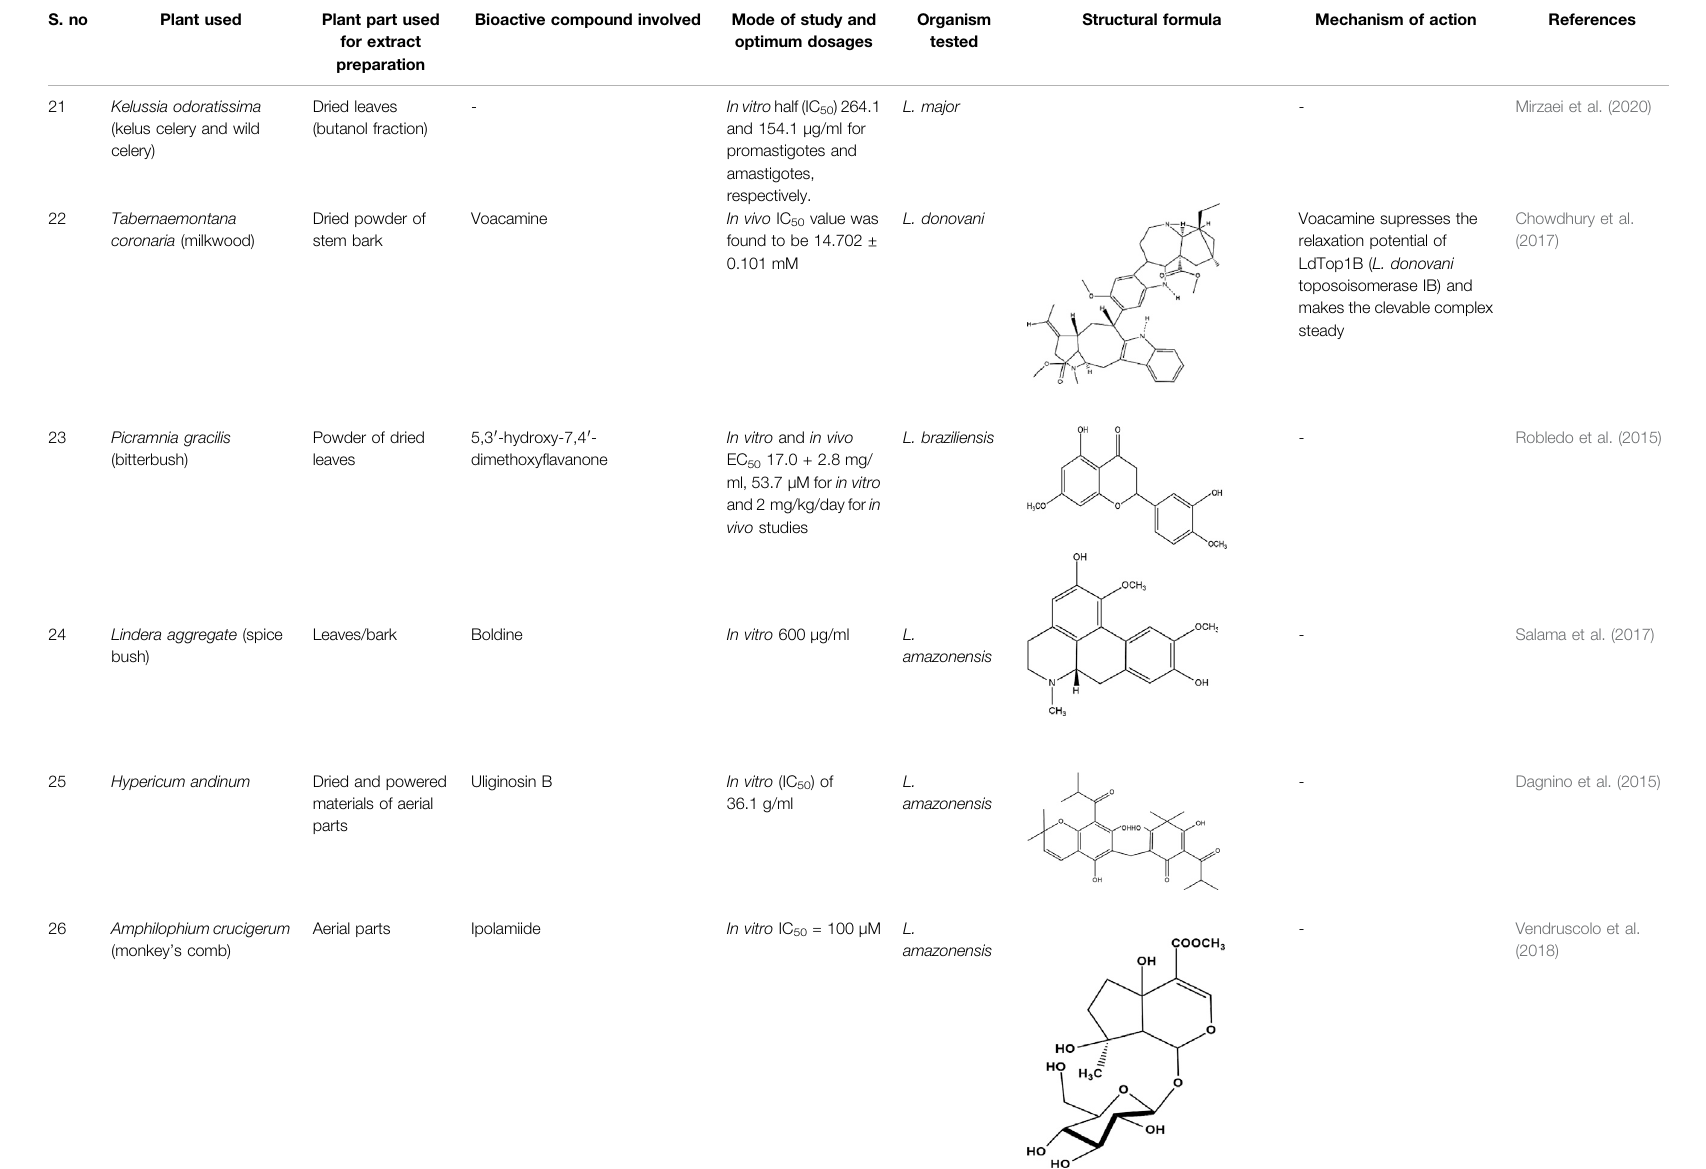
TABLE 1 | ( Continued ) Role of plant-based natural products in the treatment of